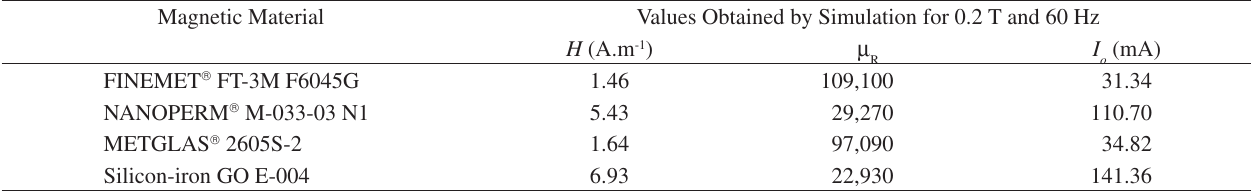
Table 2. Parameters obtained for each magnetic material by simulation. Magnetic Material